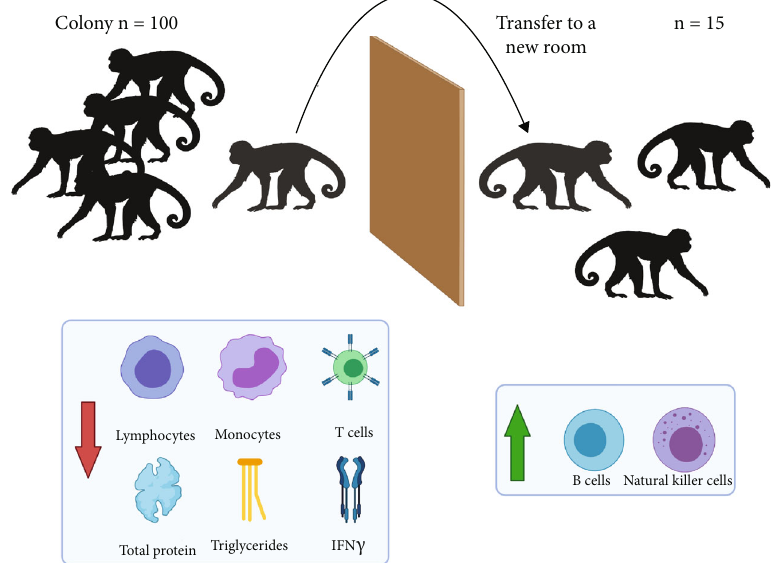
Figure 1: Schematic presentation of relocation of monkeys within the